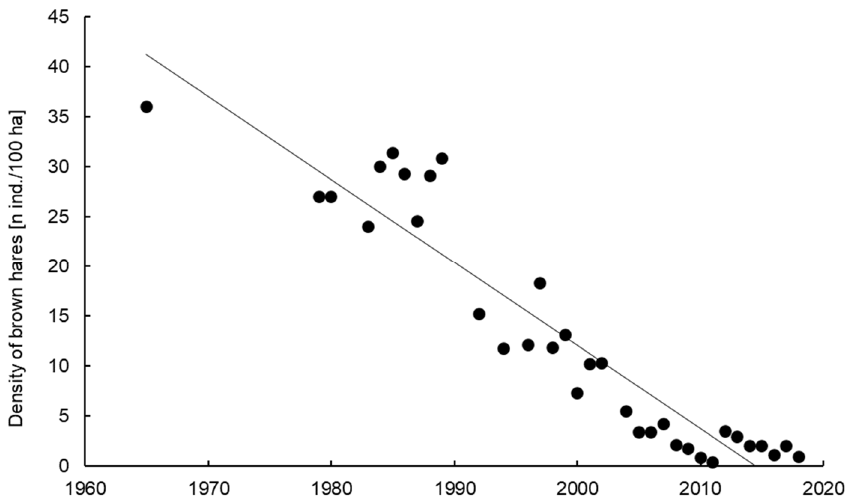
Figure 2. Decrease in the autumn brown hare density in the study area (Rogów, central Poland) as assessed on the basis of the belt assessment and spotlight counts along transect routes, in open fields, in autumn.